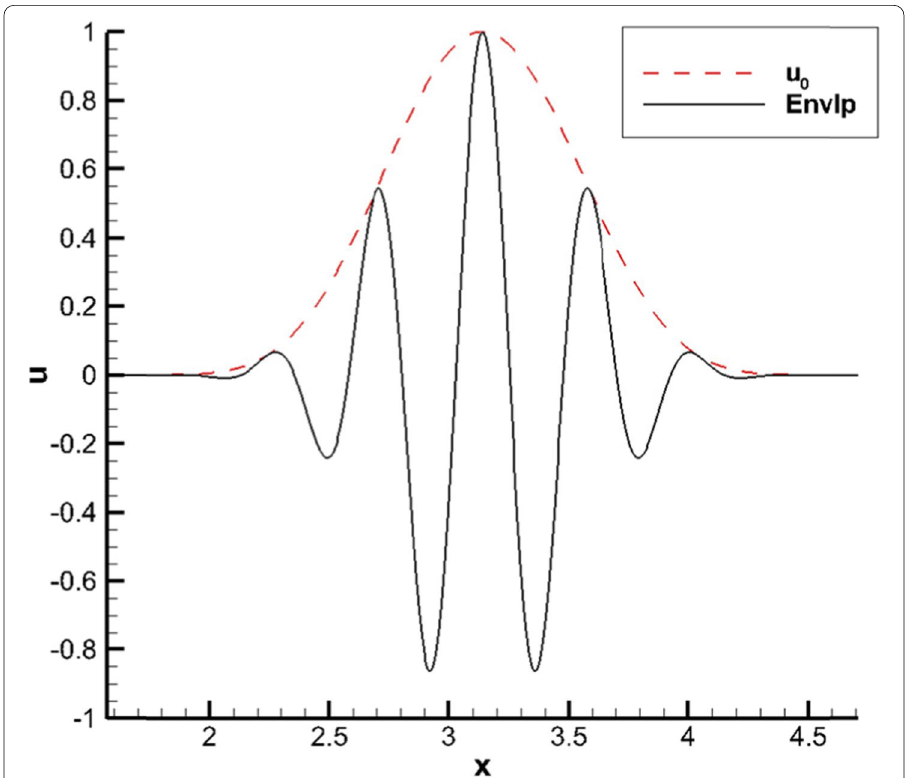
Fig. 8 Distributions of initial wave packet-like structure and its